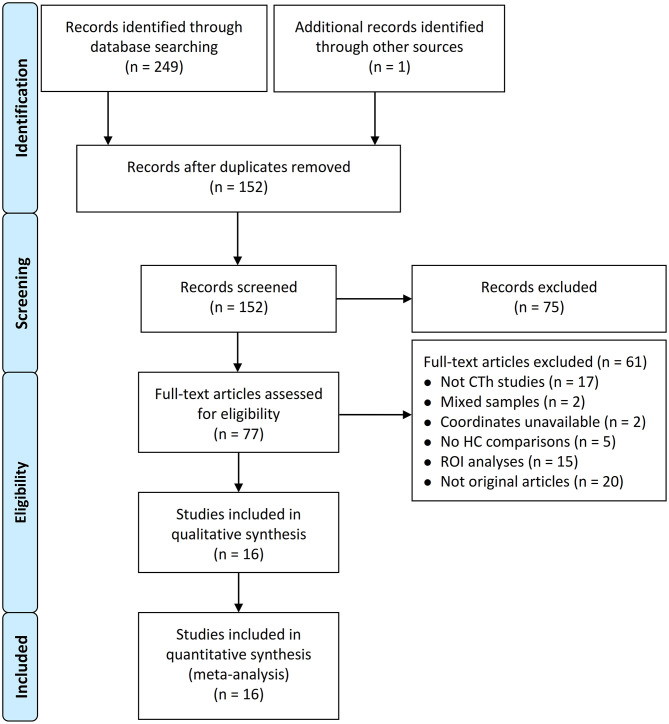
Flowchart of study selection process. CTh, cortical thickness; HC, healthy control; ROI, region of interest.